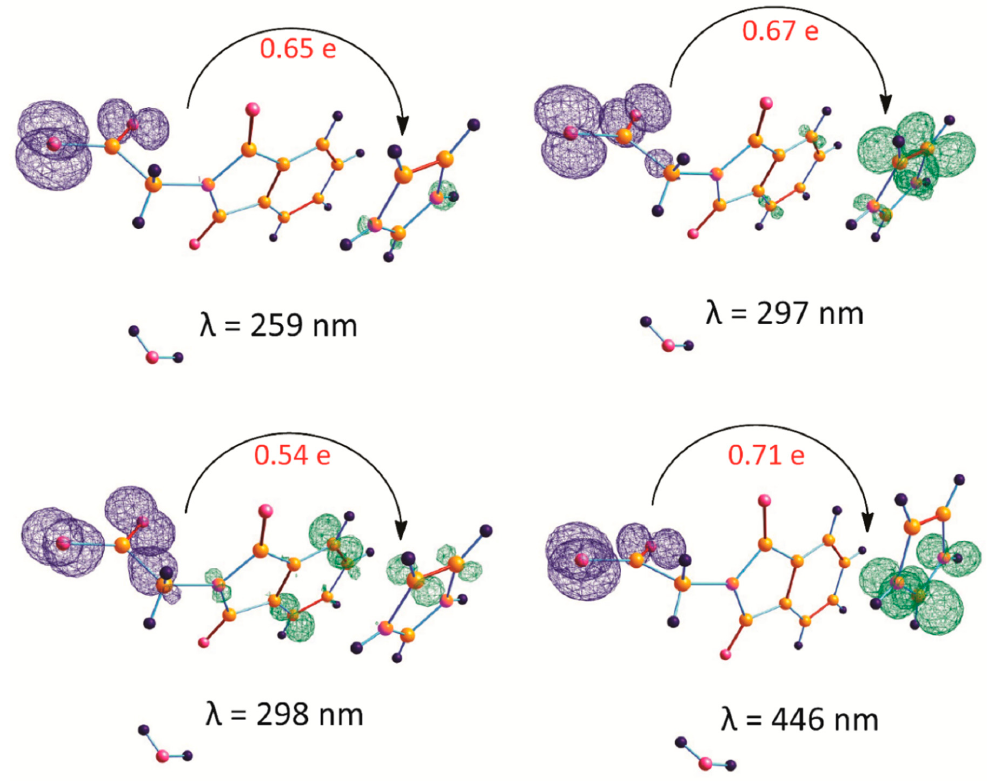
Figure 10. CDD and the extent of inter-fragment CT between the excited state and the ground state of IM + –NPG − –HYD for the absorptions at 259, 297, 298, and 446 nm. Blue and green surfaces represent the accumulation and diminution of charge concentration during excitation. The value of contour envelopes is 0.002